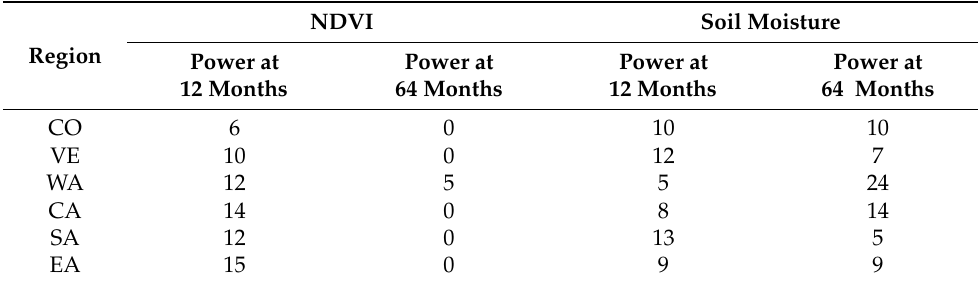
Table 5. Power of the 12-month (annual cycle) and the 64-month (ENSO) frequency bands. NDVI Soil Moisture Region Power at Power at Power at Power 12 Months 64 Months 12 Months